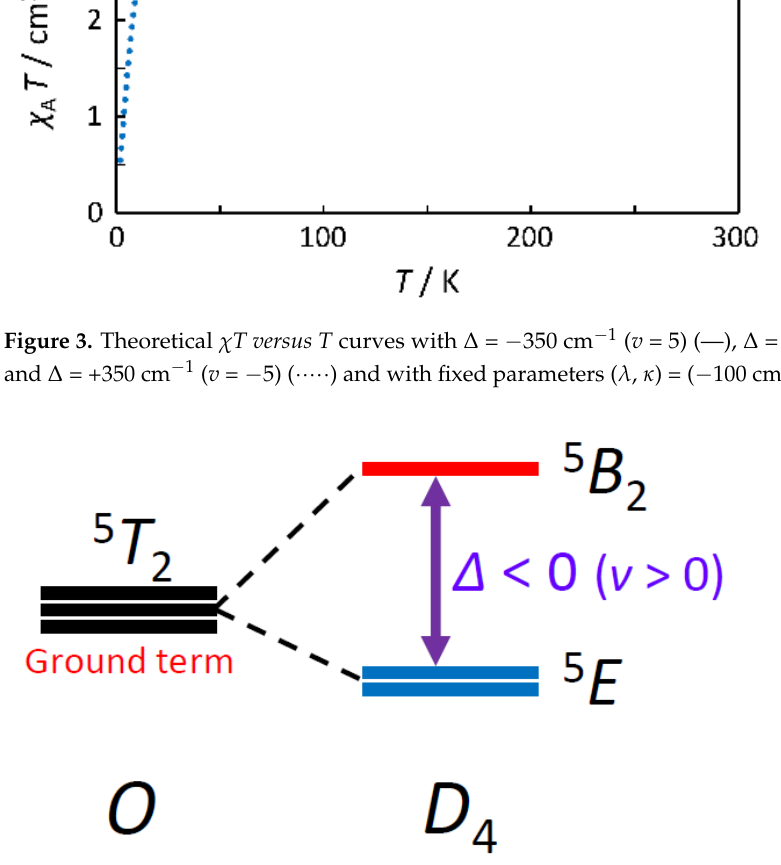
Figure 4. Energy diagram of the ground terms for the octahedral high-spin iron(II) complex. In the earlier works [1–3], the Hamiltonian had been slightly being modified with respect to handling the orbital reduction factor. Figgis and coworkers introduced the orbital reduction factor in the third term (Zeeman term) of the Hamiltonian [2], and Long and coworker further introduced the orbital reduction factor in the second term (spin-orbit coupling term) of the Hamiltonian [3]. Long and coworker used a parameter v = ∆ / λ , but in this study, we used the axiality parameter v = ∆ /( κλ ) [11], because it has some advantages in expressing coefficients. It is noted that Kahn used a parameter v = ∆ /| λ | for an octahedra high-spin cobalt(II) complexes [18]. Since our treatment is slightly different from the others, the simulation results are also slightly different from the earlier